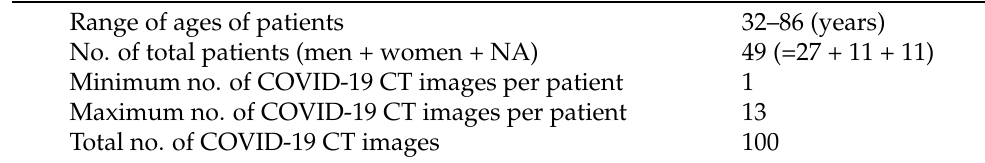
Table 1. The overall distribution of samples used in the